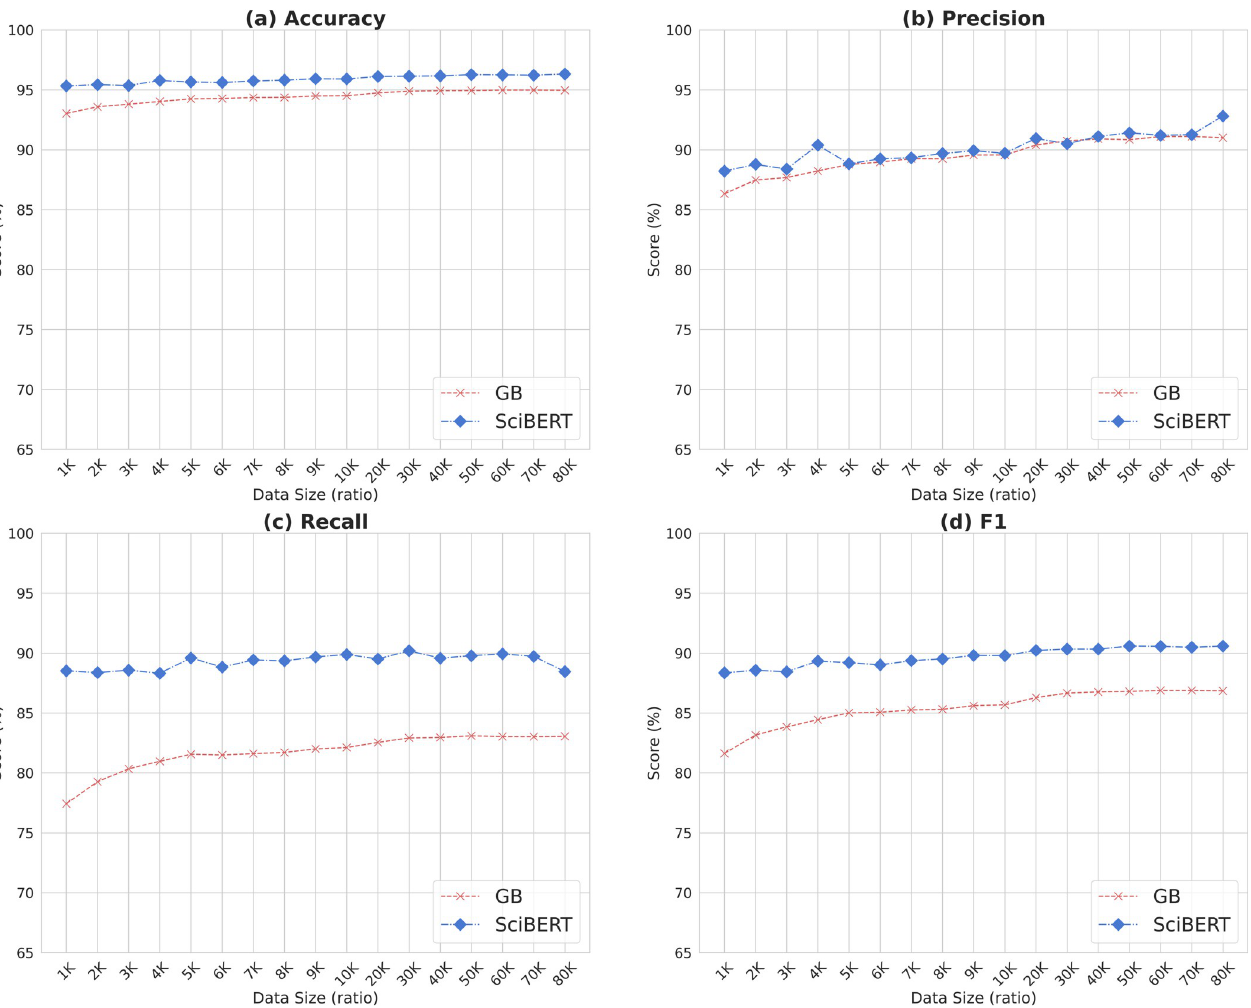
Fig 1. Distribution of average scores of four evaluation metrics for a conventional machine learning model (GB: Gradient Boosting) and BERT model (SciBERT) based on changes in data size.